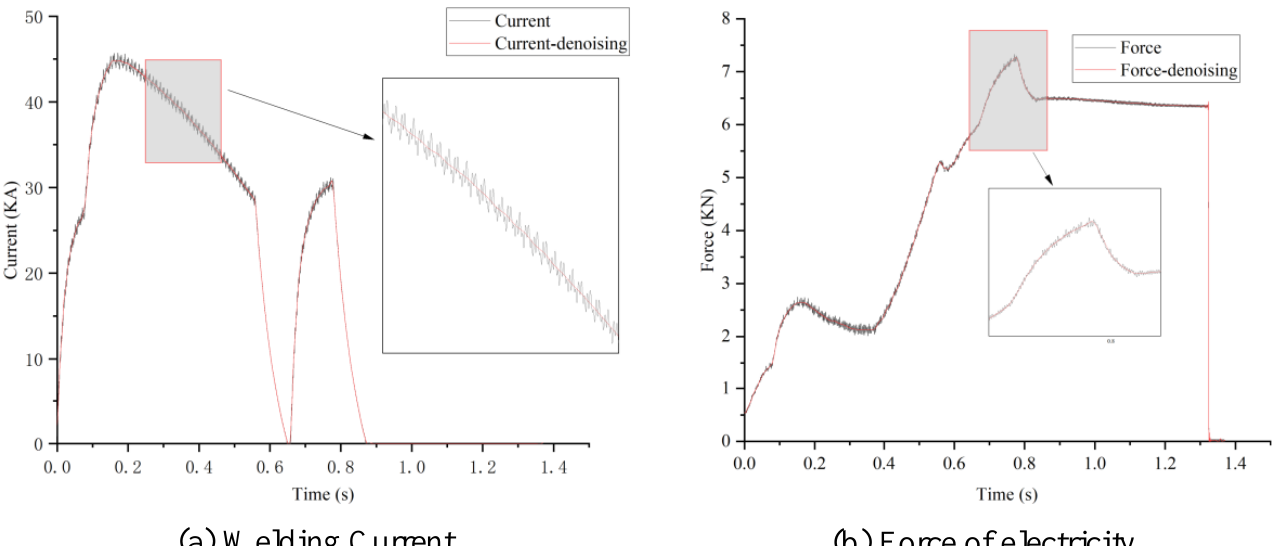
Figure 8. Curves after wavelet threshold noise cancellation, welding current ( a ), force of electricity ( b ).